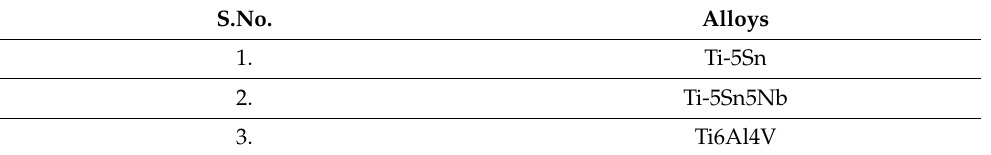
Table 2. Composition of the